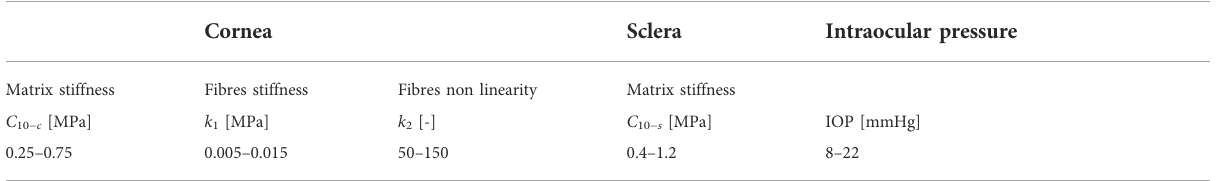
TABLE 3 Low and high parameters tested in the material sensitivity